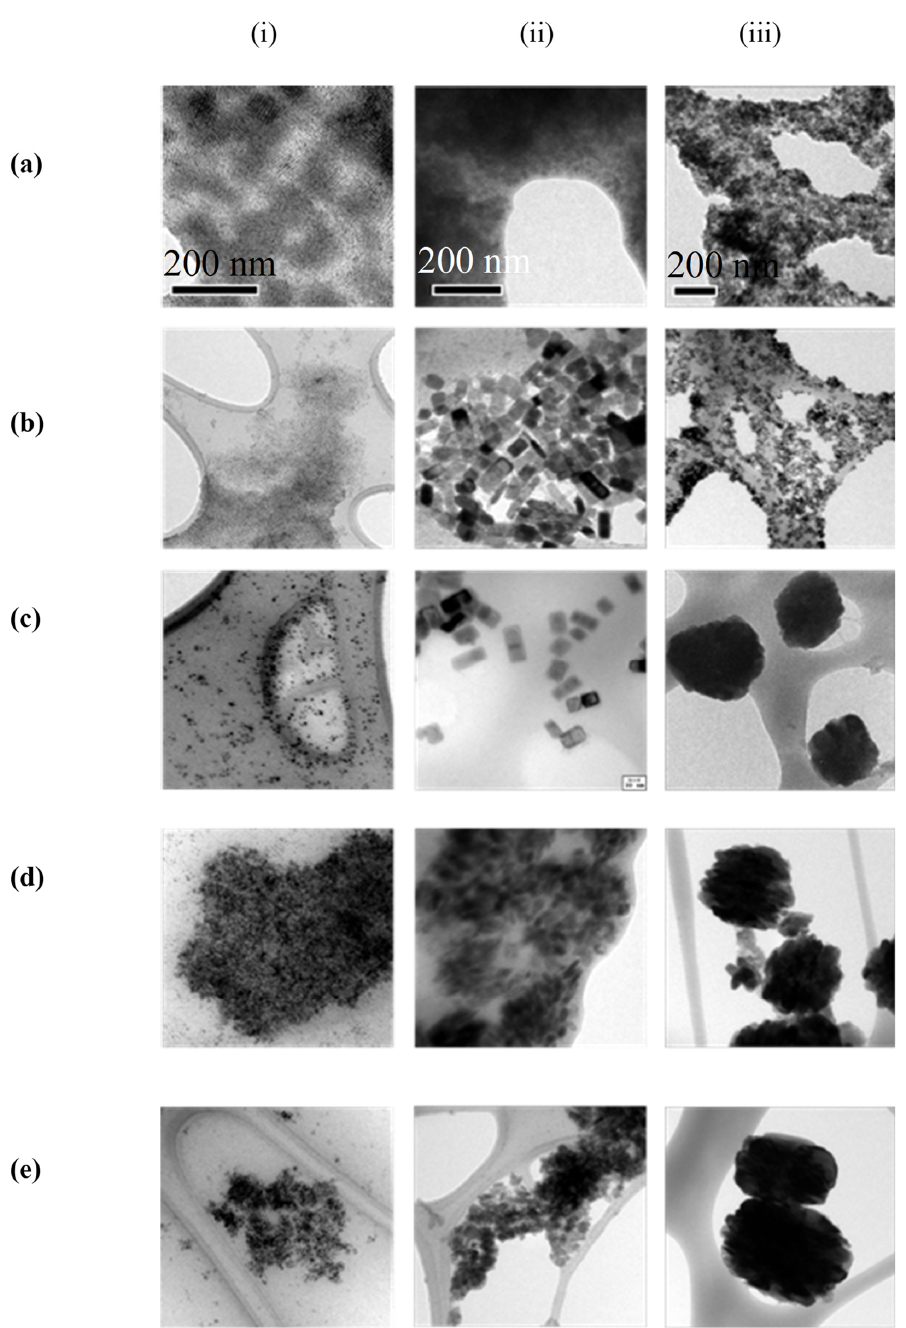
Figure 1. TEM images of column ( i ) TBA, ( ii ) ON, and ( iii ) HMTA-generated nanoparticles of column ( a ) CeO x , ( b ) Nd:CeO x , ( c ) Eu:CeO x , ( d ) Er:CeO x , and ( e ) Lu:CeO x